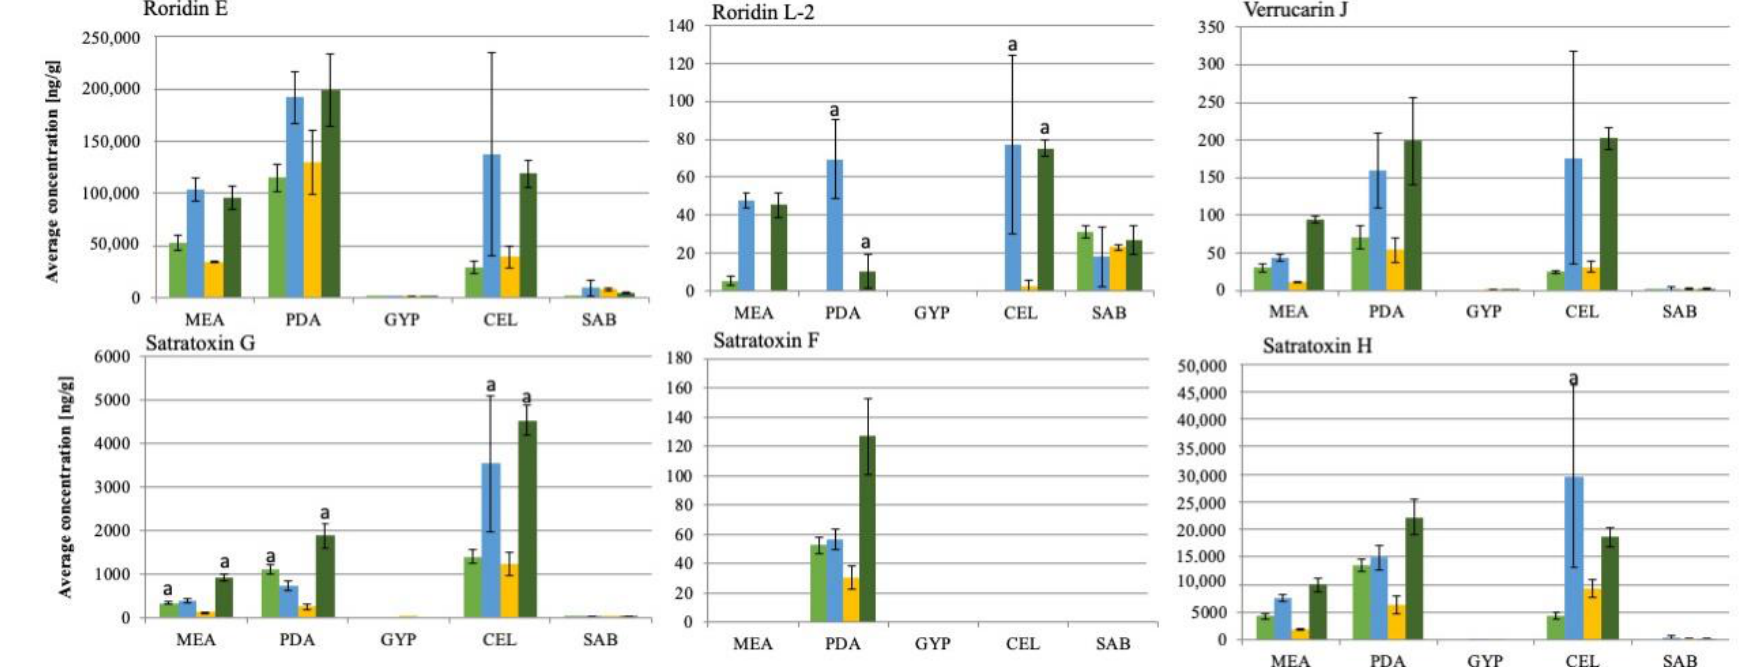
Figure 1. Average mycotoxin concentration ( n = 3) of six macrocyclic trichothecenes on di ff erent nutrition media of four di ff erent Stachybotrys chartarum genotype S strains (from left to right: S16St.; SB01a; IBT40293; ATCC34916); MEA: Malt-extract-Agar; PDA: Potato-Dextrose-Agar; GYP: Glucose-Yeast-Peptone-Agar; CEL: Cellulose-Agar; SAB: Sabouraud-Glucose-Agar; a: indicates significant di ff erences in concentrations compared to other strains ( p < 0.05).